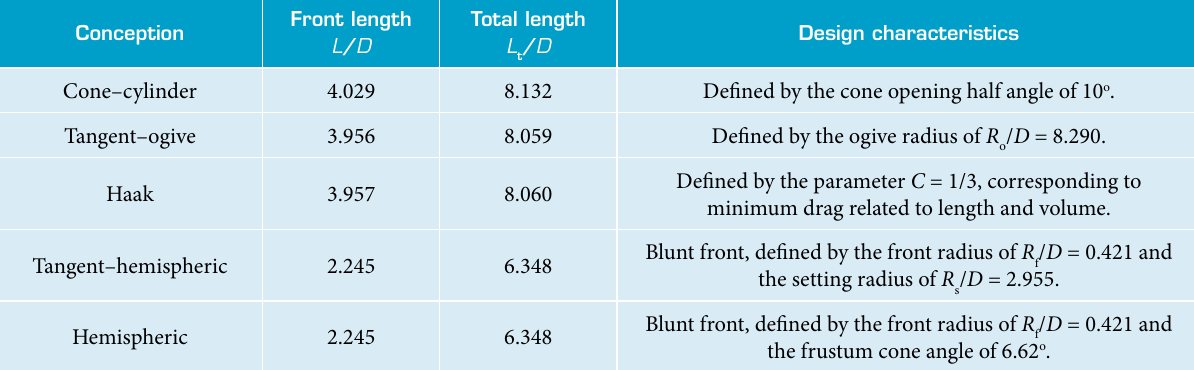
Table 1. Main dimensions of the